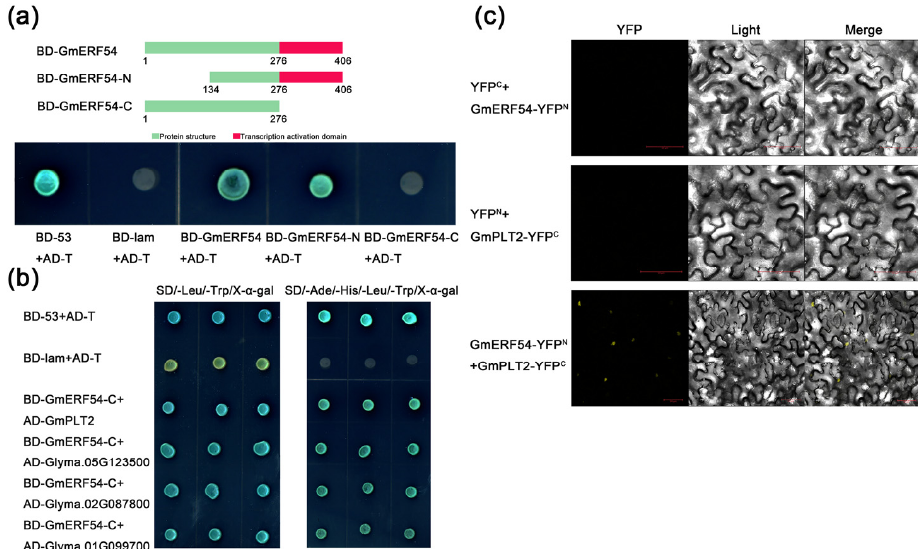
Figure 5. GmERF54 has transcriptional activation activity and interacts with GmPLT2. ( a ) Identification of GmERF54 transcription activation domain. BD-53 represents pGBKT7-53, BD-lam represents pGBKT7-lam, AD-T represents pGADT7-T, BD-GmERF54 represents pGBKT7-GmERF54, BD-GmERF54-C represents pGBKT7-GmERF54-C (C-terminal truncated 130 amino acid) and BD-GmERF54-N represents pGBKT7-GmERF54-N (N-terminal truncated 133 amino acid). ( b ) Yeast two-hybrid assay of the four proteins and GmERF54. The fact that yeast cells grew and turned blue on quadruple-dropout media (-Leu/-Trp/-His/-Ade/X- α -gal) is evidence of interaction. AD-GmPLT2 represents pGADT7-GmPLT2, AD-Glyma.05G123500 represents pGADT7-Glyma.05G123500, AD-Glyma.02G087800 represents pGADT7-Glyma.02G087800 and AD-Glyma.01G099700 represents pGADT7-Glyma.01G099700. SD/-Trp/-Leu/X- α -Gal represents double-dropout medium supplemented with X- α -Gal, and SD/-Trp/-Leu/-His/-Ade/X- α -Gal represents quadruple-dropout medium supplemented with X- α -Gal. ( c ) BiFC assay showed interaction between GmERF54 and GmPLT2 in tobacco cells. GmERF54 was fused with the N-terminal of YFP, and GmPLT2 was fused with the C-terminal of YFP. Scale bars: 50 μ m.